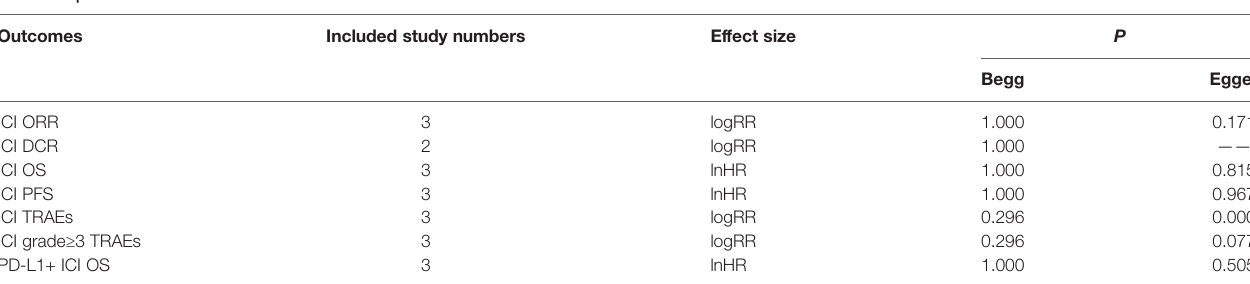
TABLE 4 | Publication bias of different outcomes.